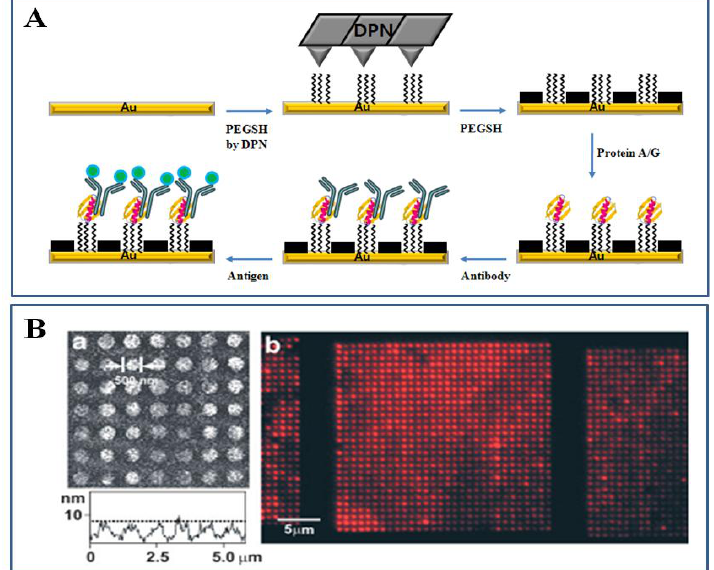
Figure 10. (A) Schematic representation of the process used to obtain biologically active antibodies on the protein A/G, which is covalently bound to NHSC SH nanoscale features 11 patterned using DPN. (B) IgG was immobilized on protein A/G nanoarrays. (a) Topographical TMAFM image and its corresponding height profile of fluorescein isothiocyanate Alexa Fluor 594-labeled human IgG nanoarrays immobilized onto protein A/G templates. (b) Representative fluorescence microscopy image of Alexa Fluor 594- labeled antibody nanoarray patterns. Reproduced with permission of Wiley